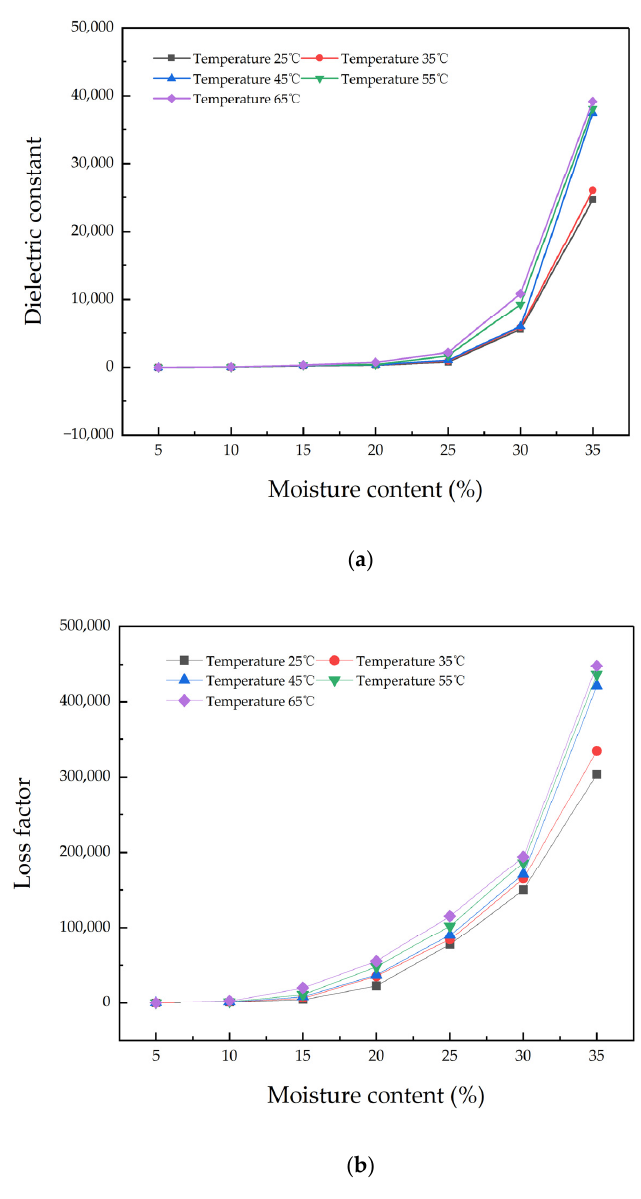
Figure 5. Moisture dependence of dielectric properties at various temperatures: ( a ) dielectric constant, ( b ) loss factor.